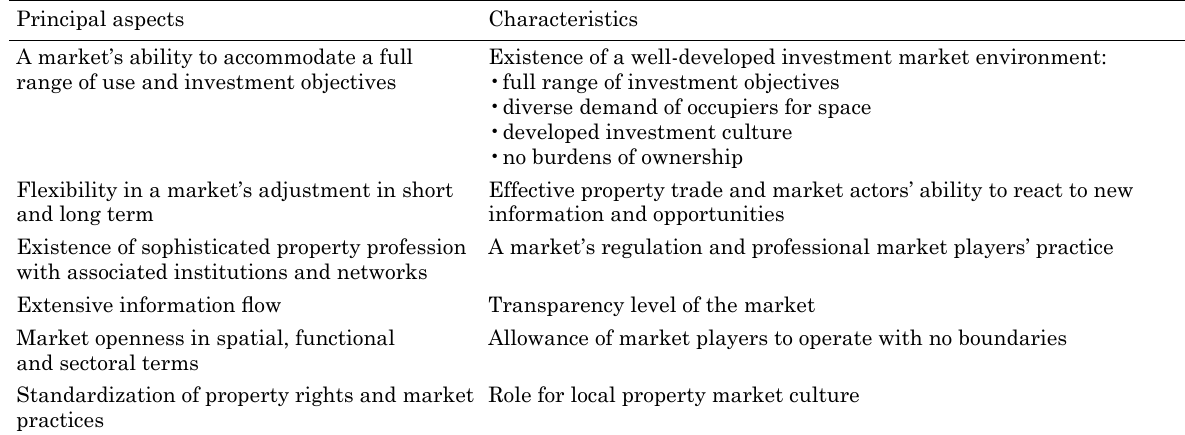
Table 1. Characteristics of a mature property market Principal